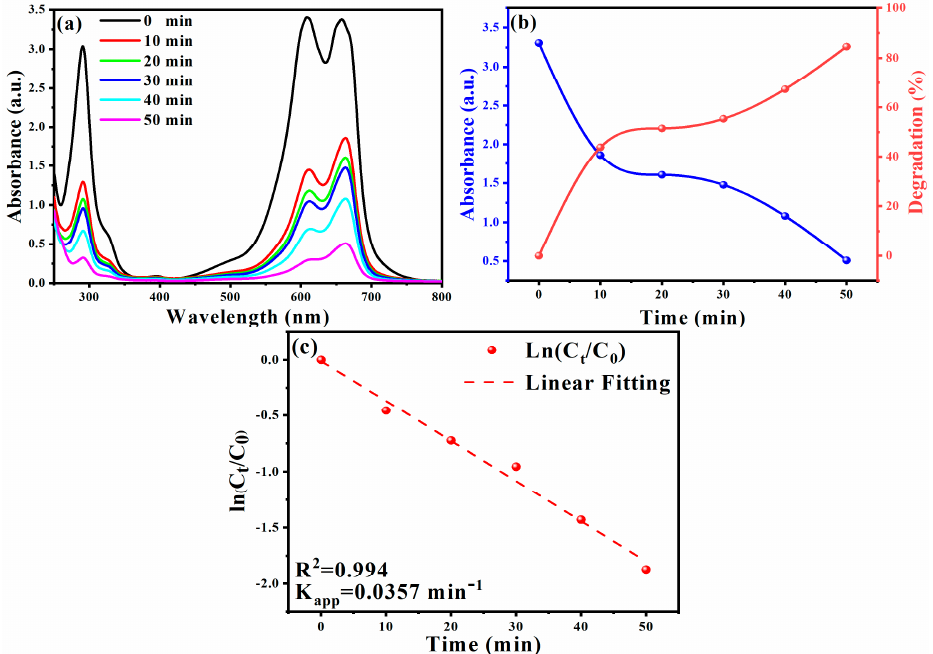
Figure 5. UV–vis spectra versus under optimal reaction conditions ( a ); absorbance and degradation versus time ( b ); the plot of ln ( C 0 /C t ) versus time ( c ) for the Ag/Ag 2 O NPs catalyzed degradation of MB dye.